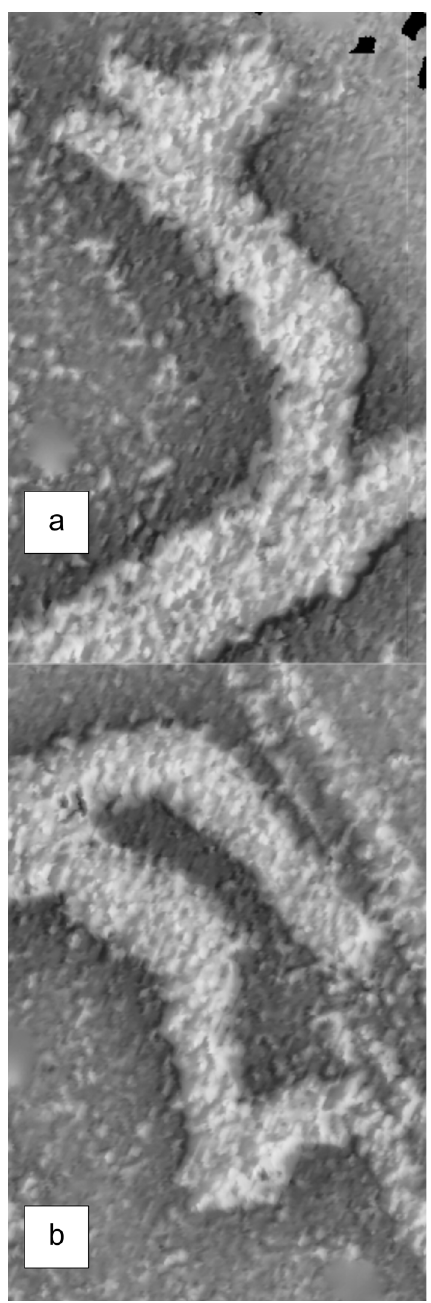
Figure 4: Horse or boat? Partial views of a boat on the panel in Bro ( Tanum 192:1 ) showing the horse - headed prow ( a ) and the aft turned upside down ( b ) . Thus, the context of the image is removed so that it could also be a horse. Visualization of 3D model ( Horn et al., 2019, 2022 ) . Documentation by Rich Potter ( GU )